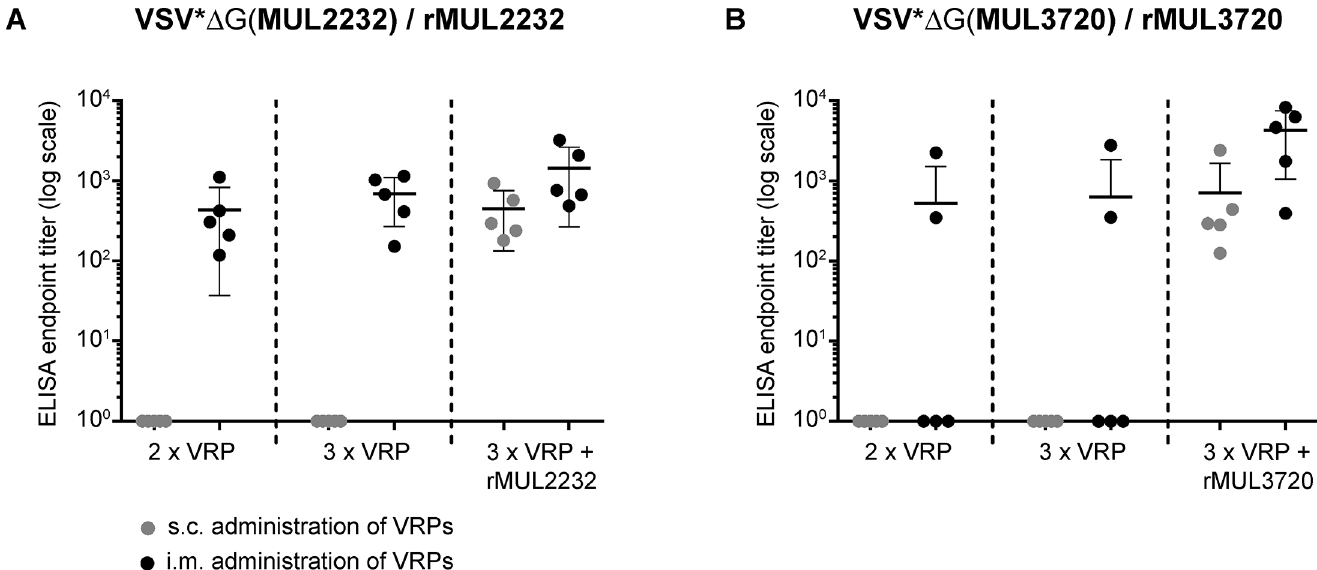
Fig 2. Comparison of immunization routes. Groups of five female BALB/c mice were sequentially immunized with VSV * Δ G(MUL2232) (A) or VSV * Δ (MUL3720) (B) via the sub-cutaneous (grey dots) or intra-muscular (black dots) route. Prior to every new immunization, blood was taken and serum analysed by ELISA on the corresponding recombinant proteins (rMUL2232 or rMUL3720). After the third immunization, all mice were boosted (s.c) with the VRP correspondent, non-adjuvanted recombinant protein. Endpoint total IgG titers were determined for individual animals in one single ELISA. Mean values (line) ± standard deviations are